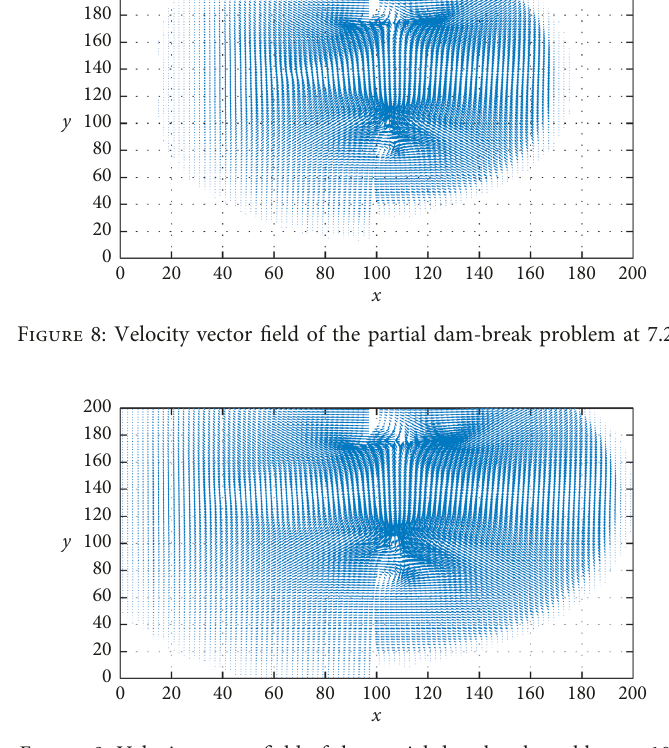
Figure 9: Velocity vector field of the partial dam-break problem at 10 s.